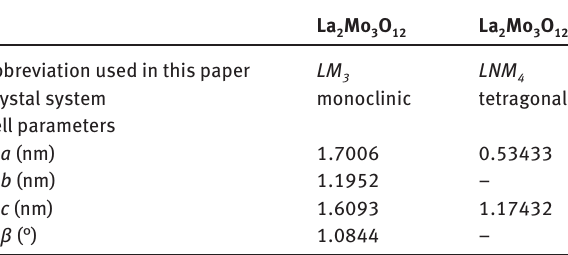
Fig. 3: Relation between interplanar spacing and n LNM